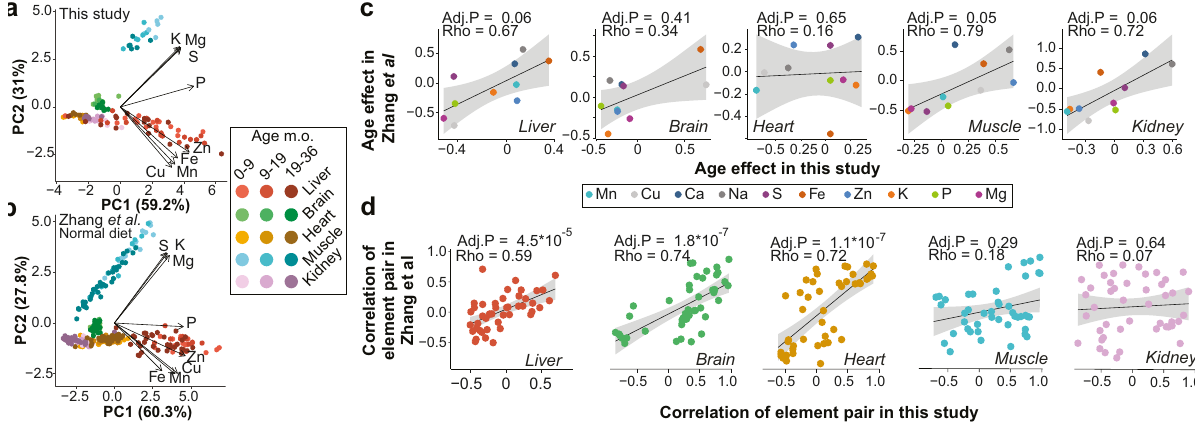
Fig. 2 The metallome organ signature and its response to stimuli are conserved across datasets. a , b Robustness of PCA analysis of the mouse metallome across different data sets. a PCA for the present study. b PCA analysis for the study of Zhang et al. 14 c Scatterplots of Spearman Rho correlation coef fi cients, and Spearman test FDR-corrected p -value calculated between metals and age in the data from Zhang et al. vs. those of the present study. The Zhang dataset measured metals at 16 timepoints at 2 months interval, as opposed to our studies ’ 3 timepoints, yet trends converge towards the same age effects in the liver, muscle, and kidney. The effects of age in the heart do not match, but are very low in both studies. d Scatterplots of Spearman Rho correlation coef fi cients and Spearman test FDR-corrected p -value calculated between pairs of metals from Zhang et al. vs. those of the present study. To enable comparisons between the two studies, data were normalized to Na in a , b and total metal concentrations in c , d . In panels c and d , the black line and gray error band represent a linear regression and its 95% con fi dence interval, respectively. Source data are provided as a Source Data fi